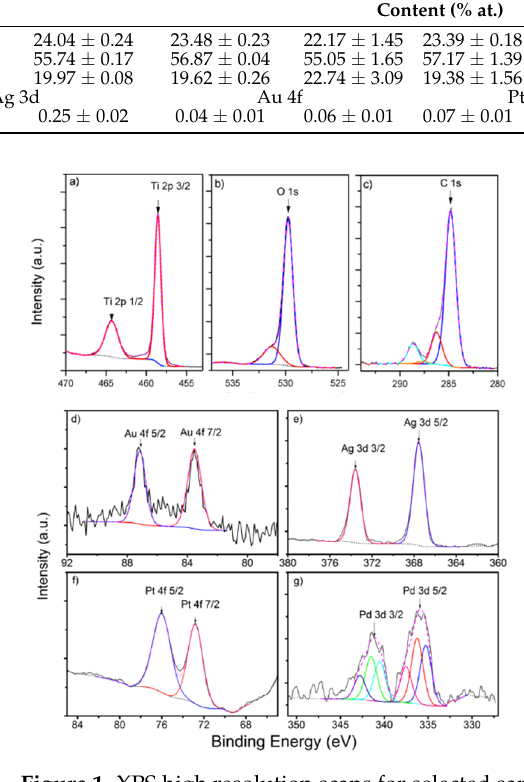
Figure 1. XPS high resolution scans for selected samples: ( a ) Ti 2p peaks for sample Ag 0.1, ( b ) O 1s peaks for sample Ag0.1, ( c ) C 1s peaks for sample Ag0.1, ( d ) Au 4f peaks for sample Au0.5, ( e ) Ag 3d peaks for sample Ag0.5, ( f ) Pt 4f peaks for Pt0.5 sample, ( g ) Pd 3d peaks for Pd0.5nr